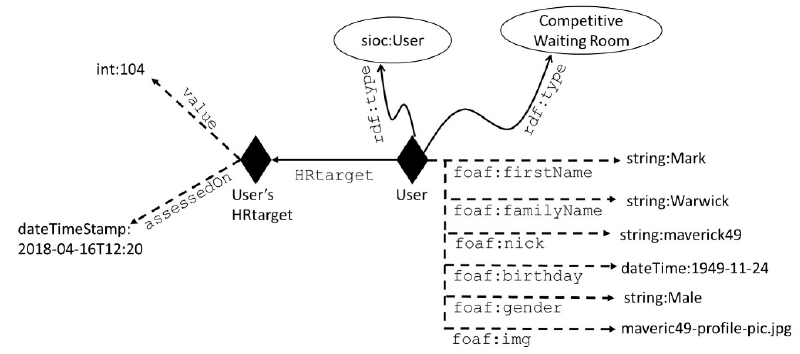
Figure 7. An example of user’s representation in the SocialBike social media network (SMN). Individuals are represented with diamonds, concepts are represented with circles, and roles are represented with arrows (dashed arrows indicate datatype properties, while full-line arrows represent object properties). The type of an individual is stated with a curved arrow.